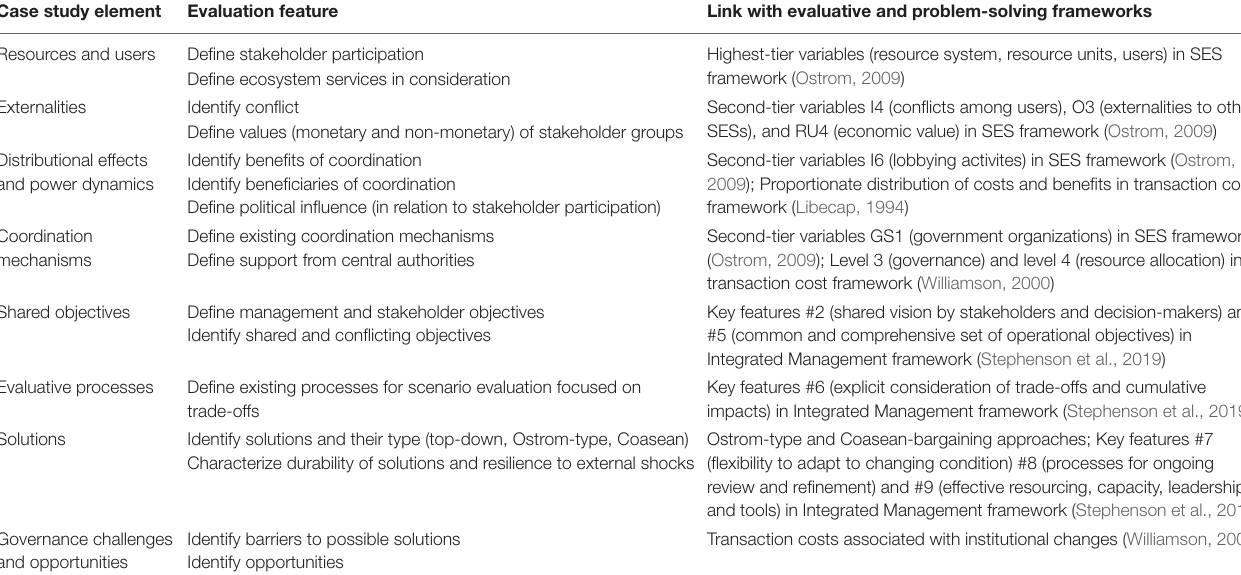
TABLE 1 | Common framework for evaluating case